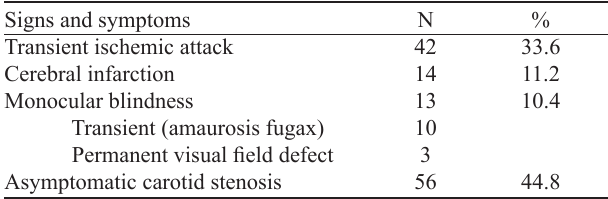
Table 1. Indications for carotid endarterectomy (125